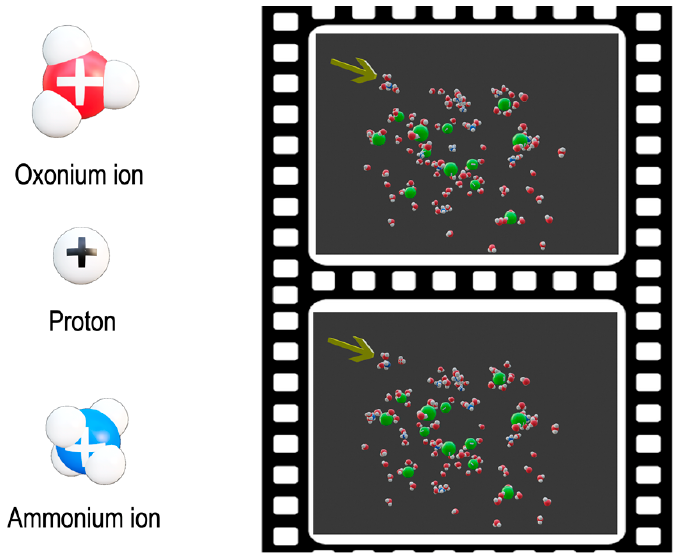
Figure 2. Example from the filmstrip of the first experiment (translated into English). To generate the AR environment, an iPadOS application was created by using the models and animation from Blender. Those models were imported into the software Unity 3D. In addition, the Vuforia SDK was used to implement AR functionalities. In the main menu (see Figure 3), students had to select the right environment and scan the corresponding marker to prevent them from looking at other content before it was relevant. Marker-based AR was chosen, as this is the most common type of AR. Furthermore, the marker can easily be placed next to the experiment (see Figure 3), and visualizations are presented in a stable way even if the camera cannot track every single moment. One marker was created for the training and one for each experiment. To give the students more control over the AR animations, a pause button was integrated in the same way as in the animation group, so the students could stop at any time. Due to technical issues, a rewind or fast-forward button could not be added. Rotation and zoom were possible by moving the device or the marker. The whole program was exported to XCode for compilation and final deployment on the iPads. Since the app is still in beta, it is not yet publicly available through the Apple App Store (see Supplementary